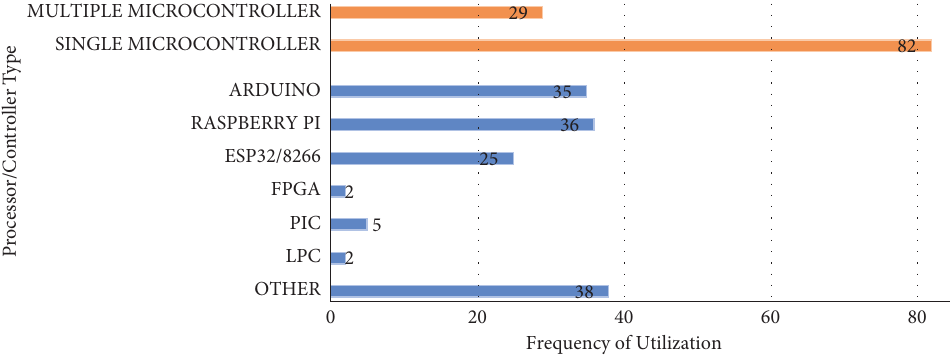
Figure 9: Comparison of microcontroller usage in SHSs.